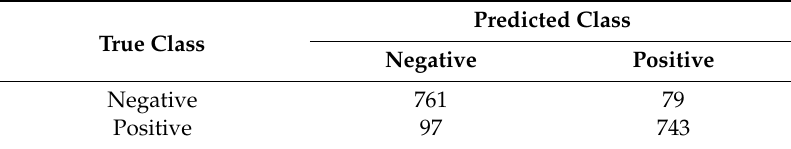
Table 4. Deep FC1 features and DT classifier.